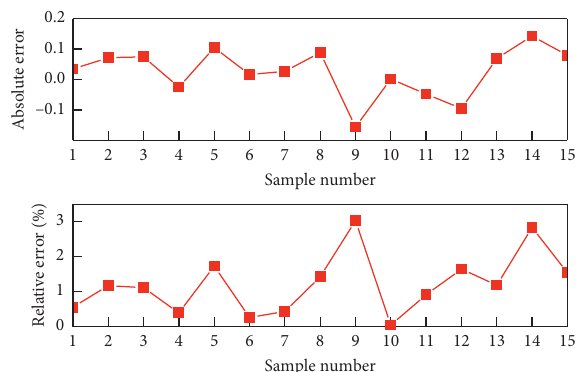
Figure 7: Absolute error and relative error of BA-ELM face. Compared with the tested gas content, the average absolute error is 0.069, the average absolute percentage error is 0.012, and the determination coefficient is 0.981, illustrating an improved pre- diction accuracy.